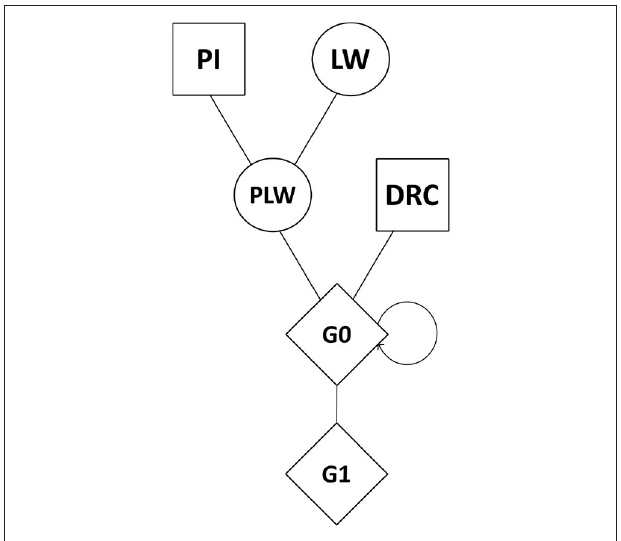
FIGURE 1 | Crossbreeding scheme. Squares represent males, circles represent females, and diamonds represent unspecified gender. DRC, Duroc; G0, (Pietrain × Large White) × Duroc offspring; G1, G0 × G0 offspring; LW, Large White; PI, Pietrain; PLW, Pietrain × Large White.